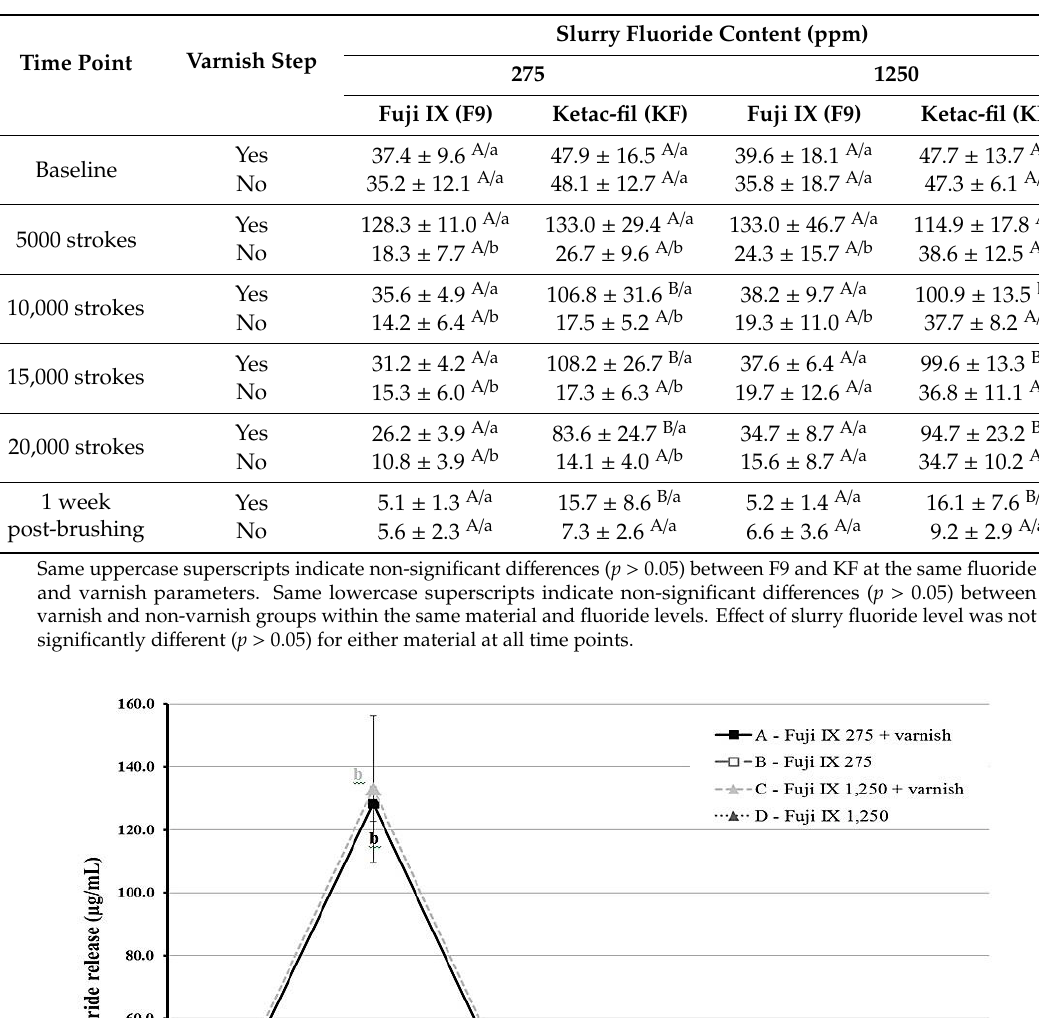
Table 2. Mean and standard deviation of fluoride release ( µ g / mL) among the di ff erent groups at di ff erent time points.